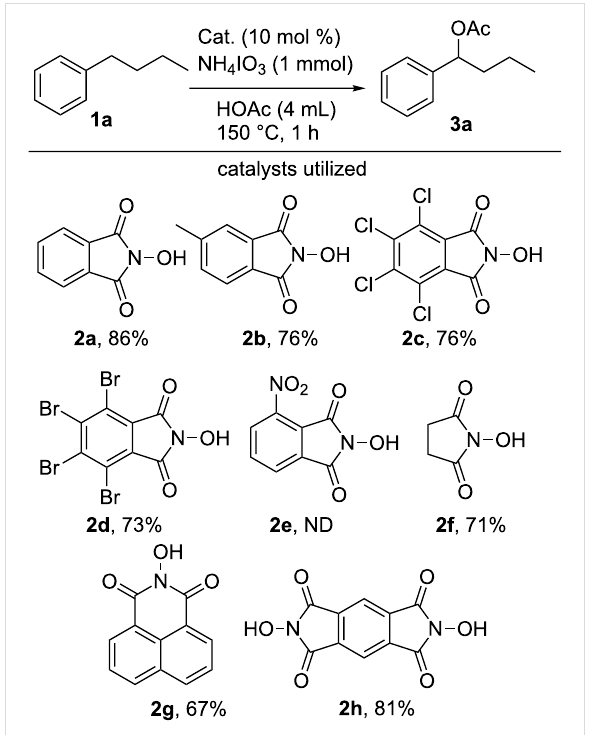
Figure 1: Catalyst optimization for the monooxidation of n -butylben- zene mediated by the iodate anion.